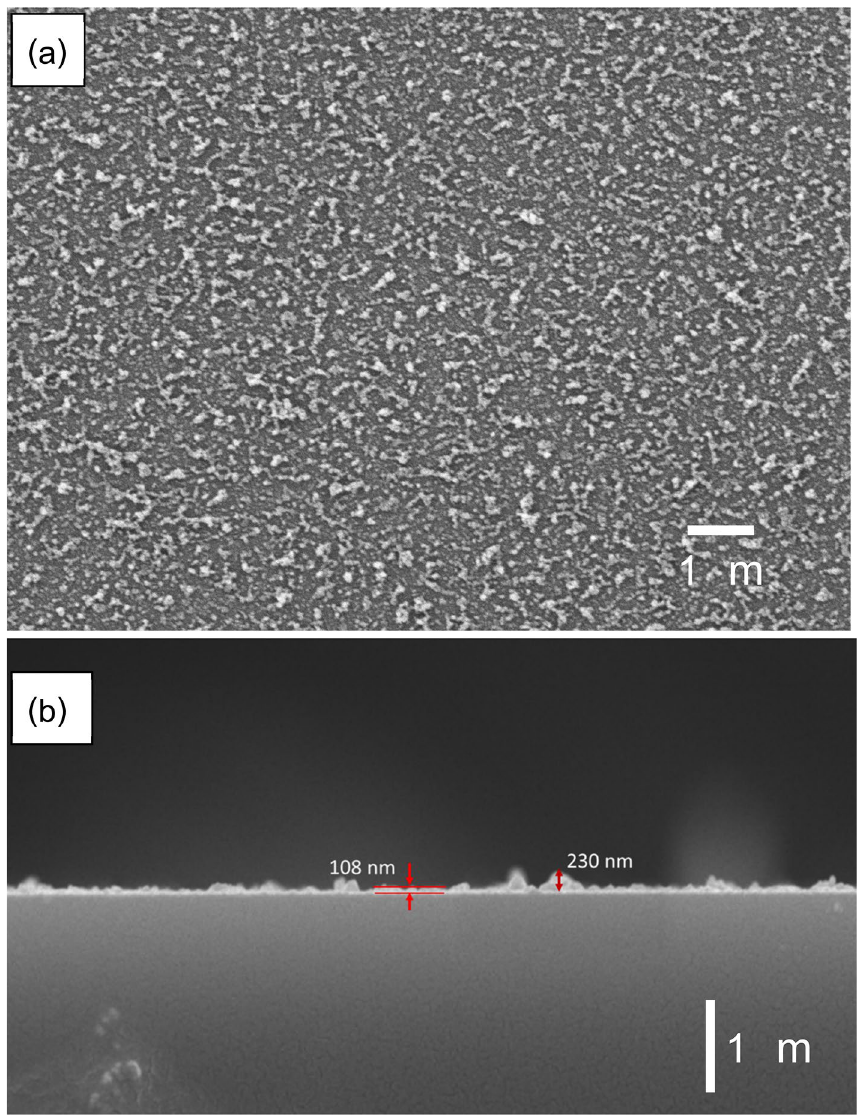
Figure 6. SEM images of top view ( a ) and cross-section ( b ) of glass slide submitted to eight